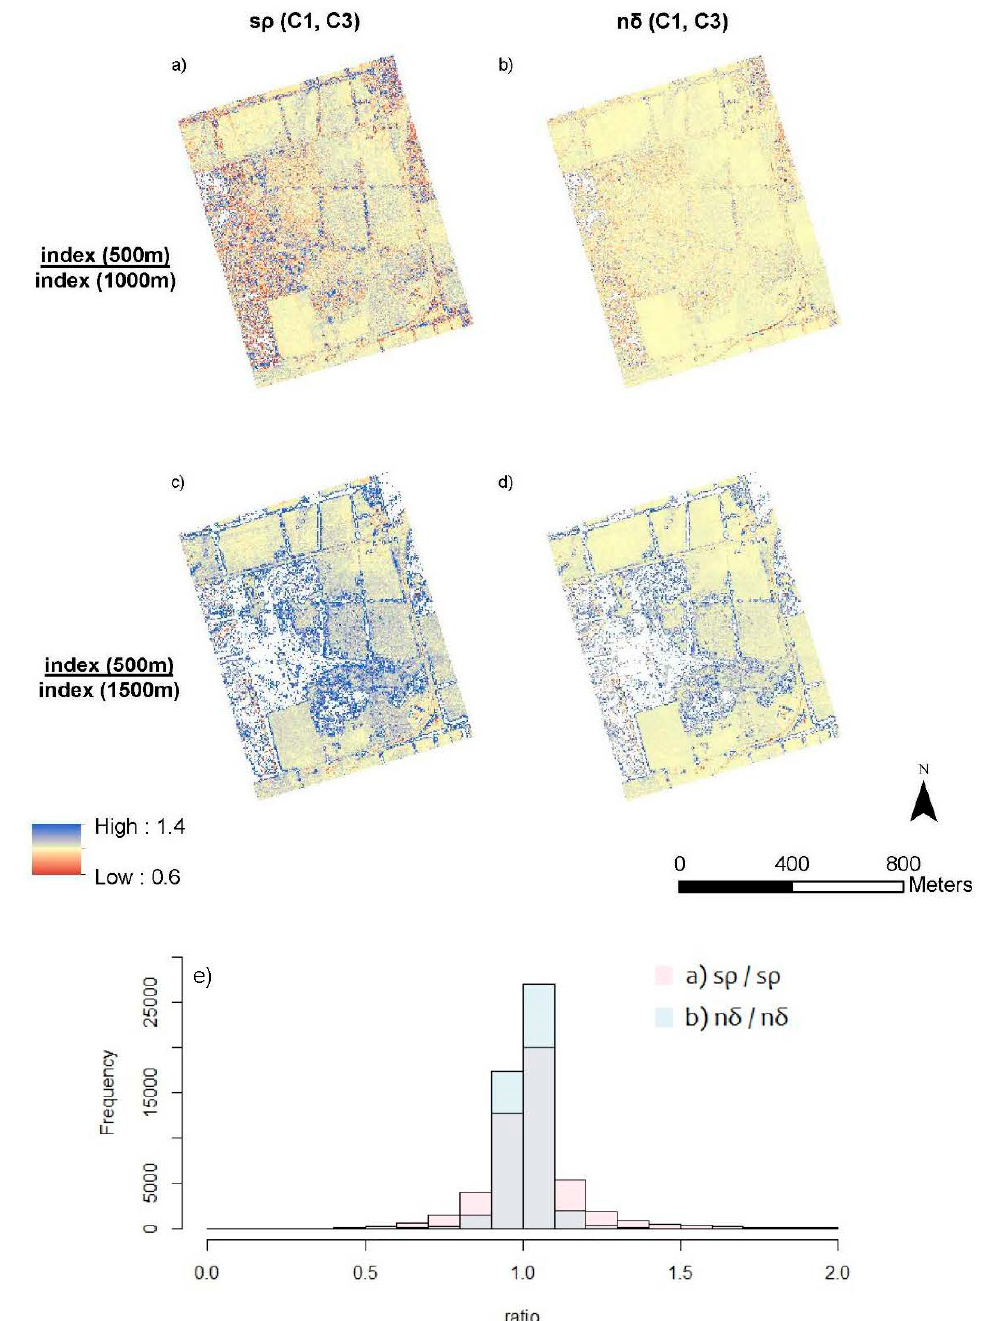
Figure 11. Ratios derived from single return indices at 4 m × 4 m grid: ( a ) ratios of s ρ (C1, C3) at 500 m to s ρ (C1, C3) at 1000 m; ( b ) ratio of n δ (C1, C3) at 500 m to n δ (C1, C3) at 1000 m; ( c ) Ratios of s ρ (C1, C3) at 500 m to s ρ (C1, C3) at 1500 m; ( d ) ratio of n δ (C1, C3) at 500 m to n δ (C1, C3) at 1500 m. ( e ) histograms for Figure 11a,b. White pixels represent no data.